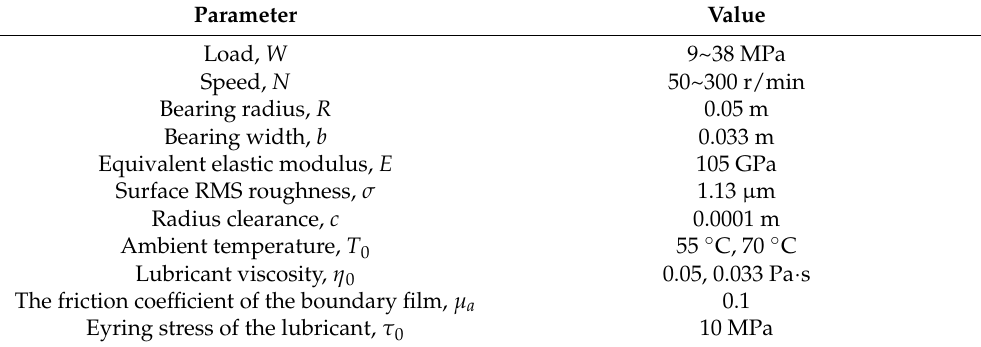
Figure 12. Schematic diagram of the loading structure. Table 3. Experimental parameters.